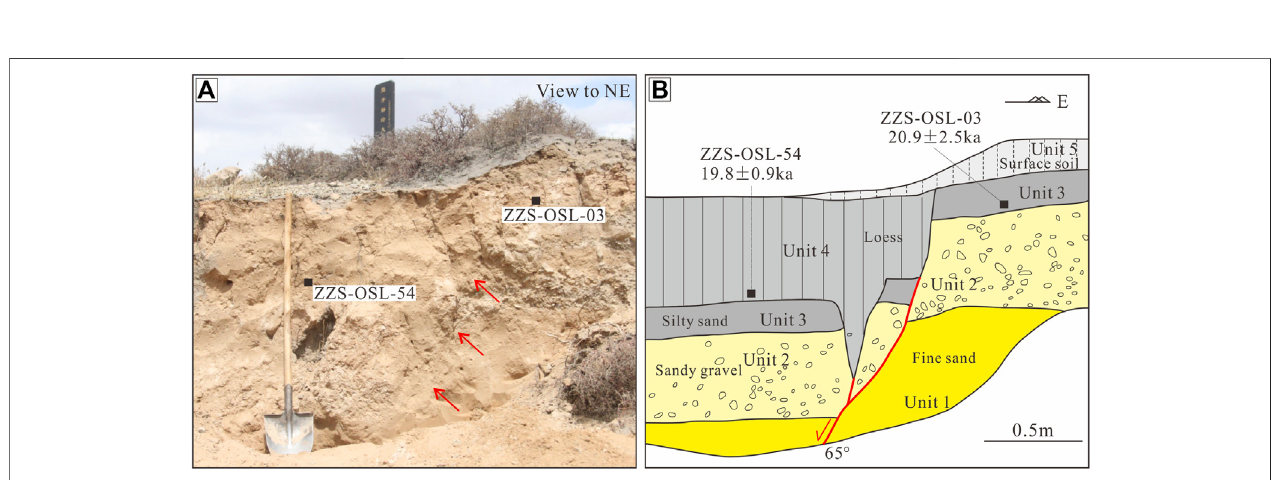
FIGURE3|(A) Hill-shadedreliefmapfromhigh-resolution DEMdataillustratingthedistributionoffaultscarpsattheLingyuansite (B) Interpreted geomorphicmap with 0.5 m interval contours showing the fl uvial terraces, normal fault scarps and sampling positions at the Lingyuan site. Three levels of river terraces are mapped according to their morphologic features and different heights above the channel in fi ll.